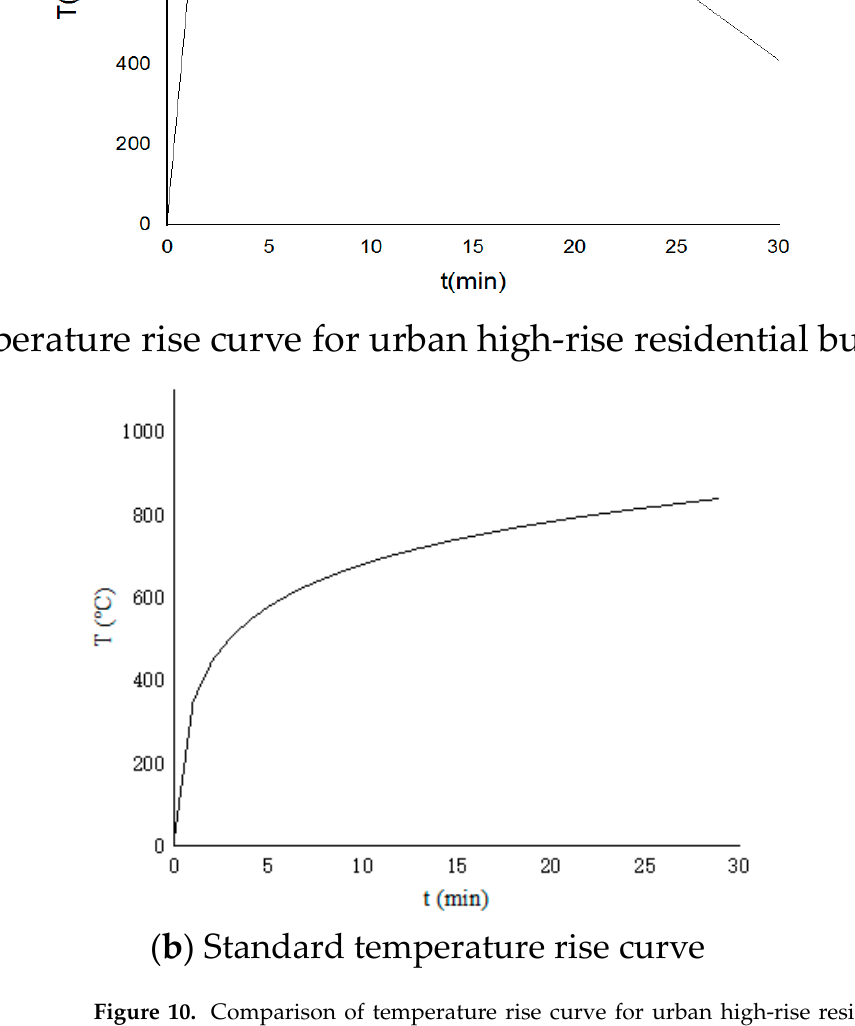
Figure 10. Comparison of temperature rise curve for urban high-rise residential buildings and standard temperature rise curve.